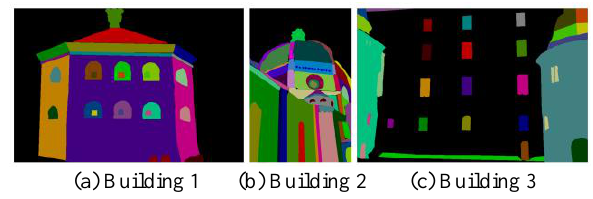
Figure 12 .The groundtruth data of the buildings. Images